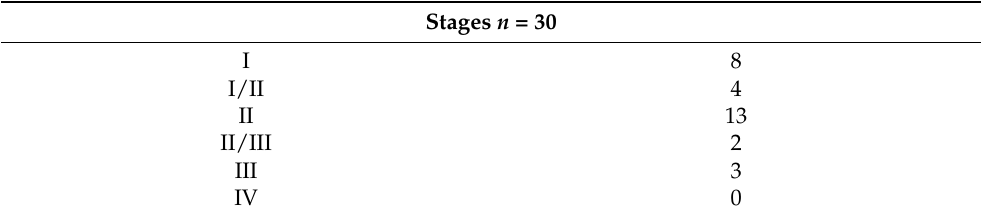
Table 2. MN stages (light microscopy). Number of patients ( n ).